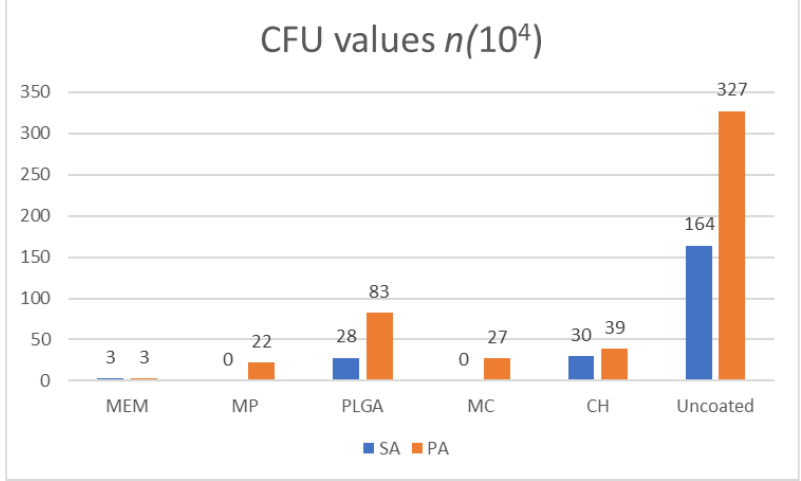
Figure 2. CFU count for SA and PA against the tested materials.